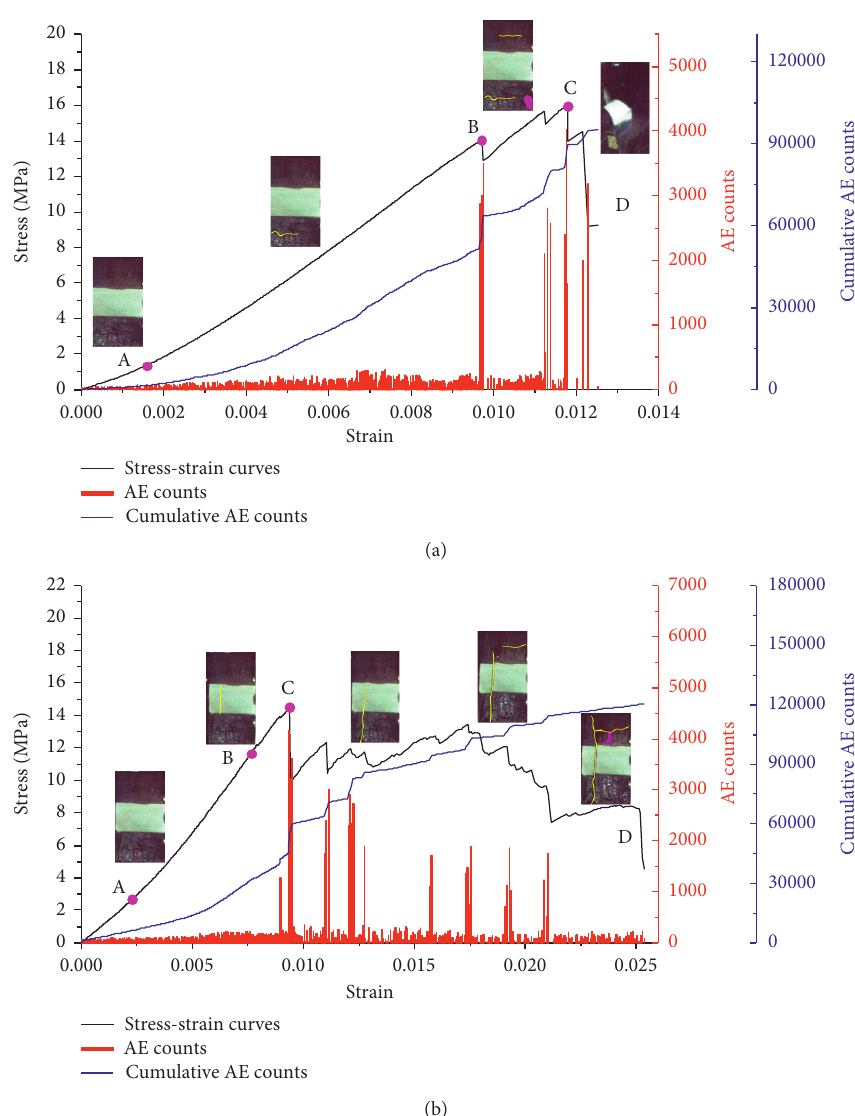
Figure 11: Stress-strain curve and acoustic emission monitoring curve of 30mm-thick composite specimens. (a) B30-1. (b) B30-2.